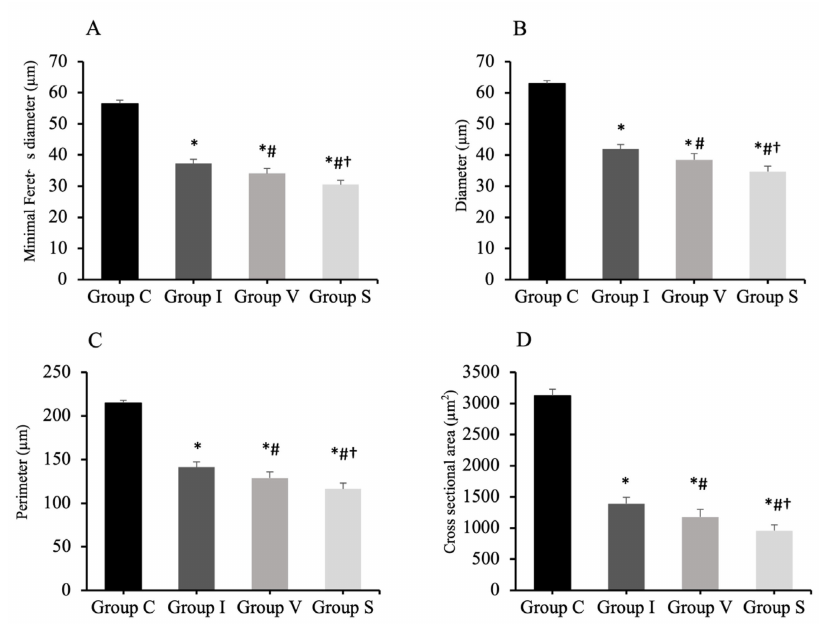
Figure 4. Minimal Feret’s diameter ( A ), diameter ( B ), perimeter ( C ), and cross-sectional area ( D ) of quadriceps muscle fiber analyzed by H&E staining. Group C, control group; Group I, cast immobilization group; Group V, Velcro immobilization group; Group S, spiral wire immobilization group. Values are expressed as mean and standard deviation. *; Significant difference from Group C ( p < 0.0001). #; Significant difference from Group I ( p < 0.0001). †; Significant difference from Group V ( p <